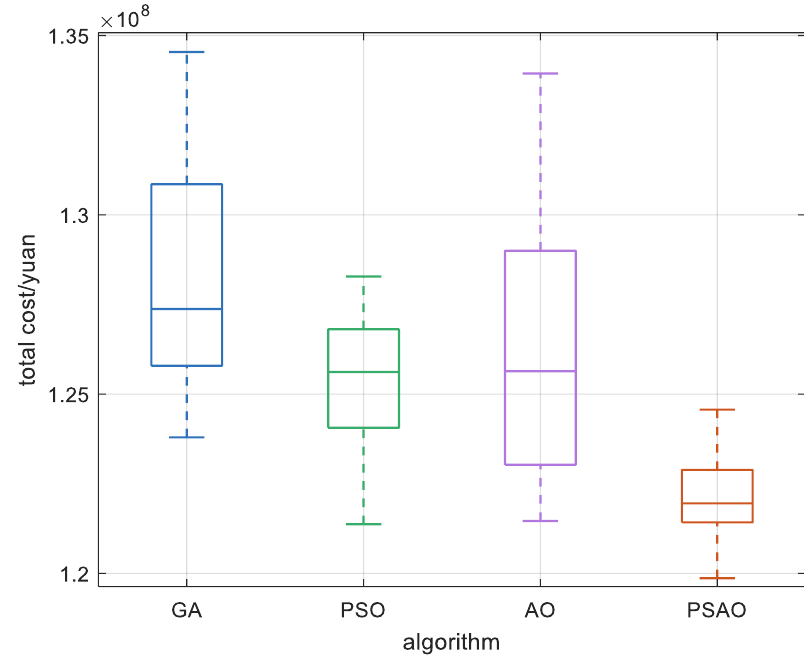
Figure 7. Box plots of total cost.